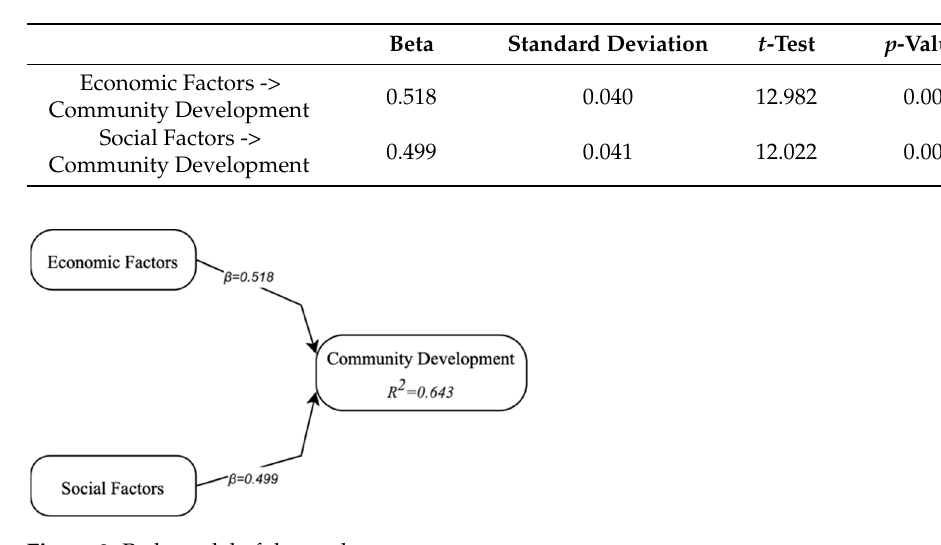
Figure 3. Path model of the study.